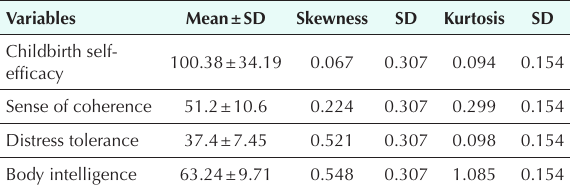
Table 1. The mean scores and normality testing parameters of the study variables Variables Mean ± SD Childbirth self- efficacy